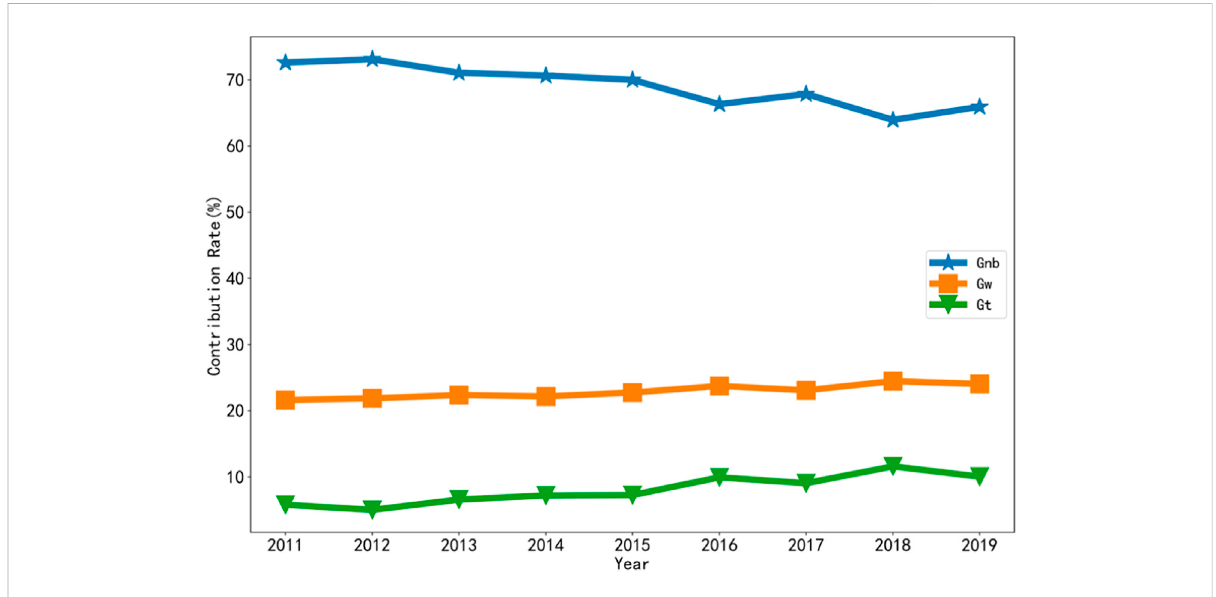
FIGURE 6 Decomposition of Gini coef fi cient differences and their contribution